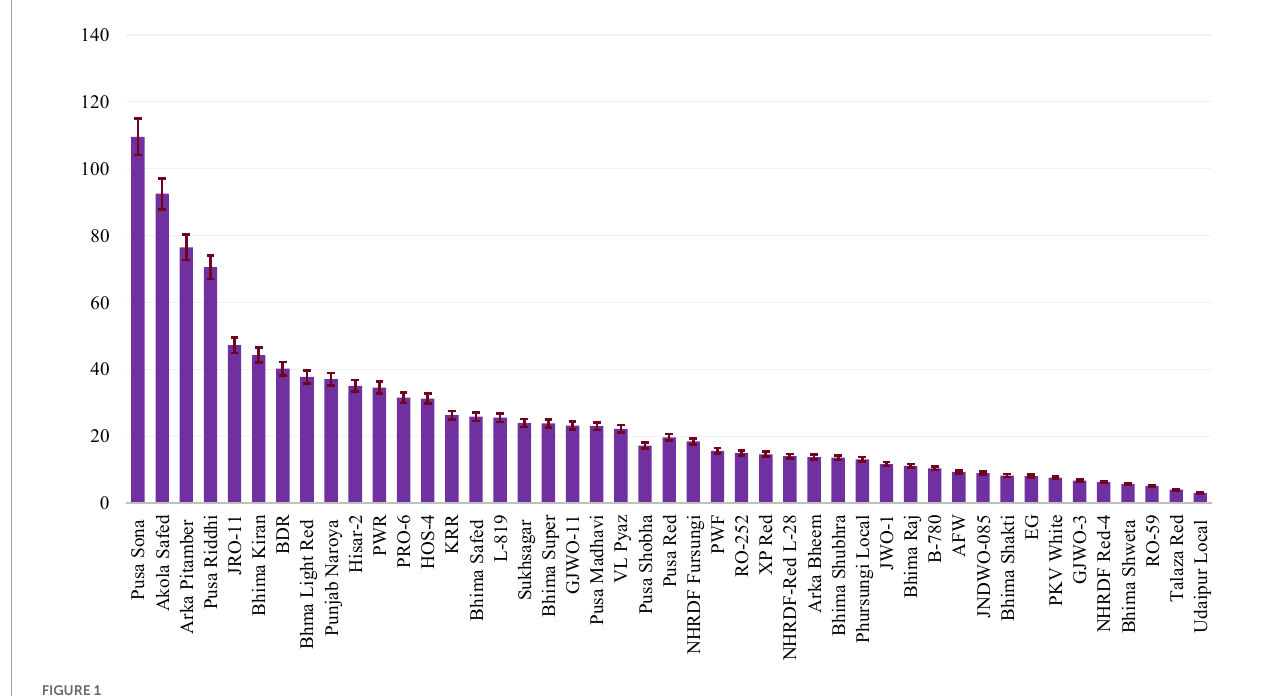
FIGURE1 Potassium to sodium ratio in the 45 Indian short day onion